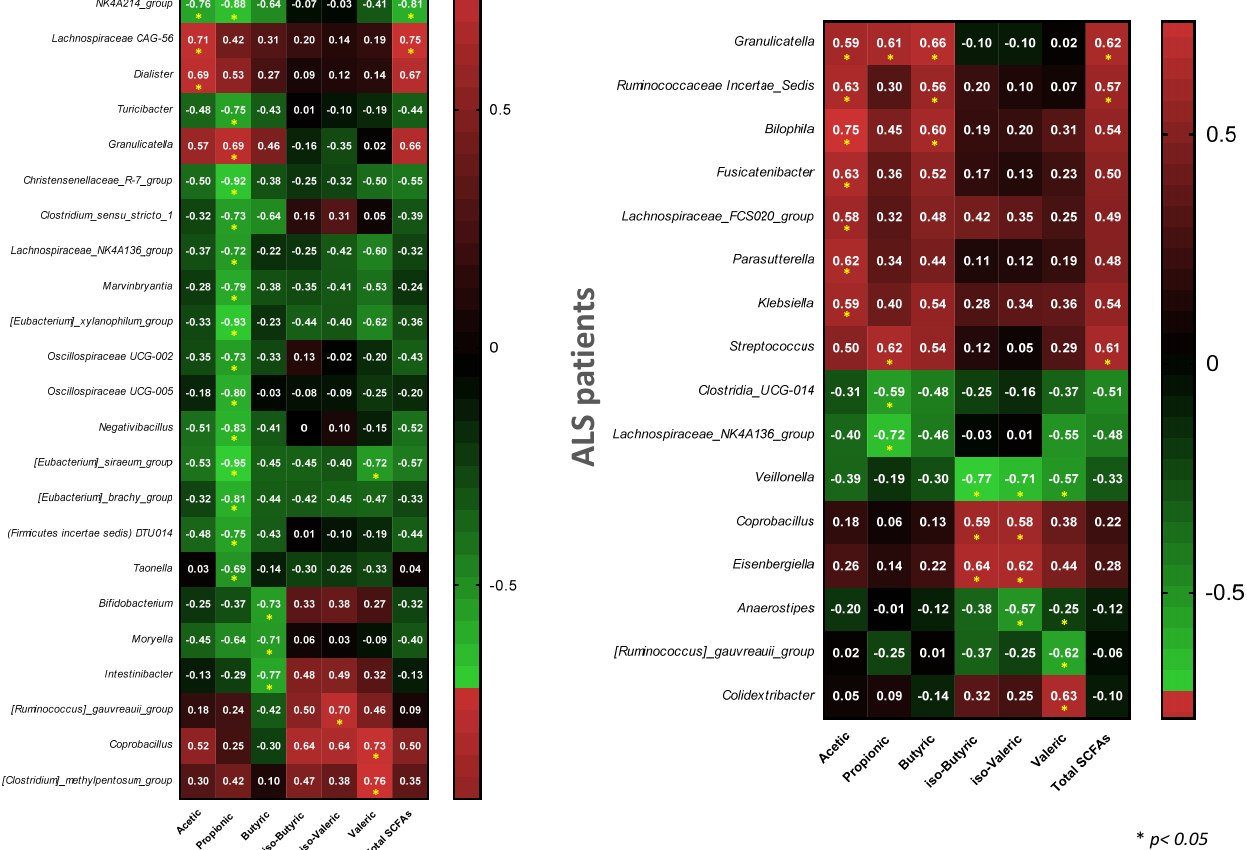
Figure 7. Heatmap of significant correlations (Spearman) identified between taxa relative abundances and levels of fecal SCFAs in ALS patients and healthy controls.